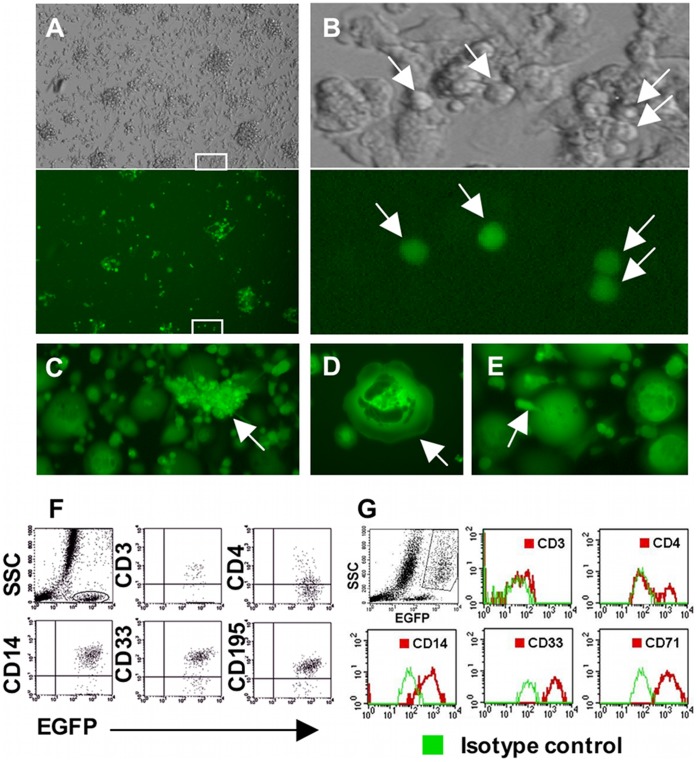
Small monocytoid cells are susceptible to HIV-1 entry leading to productive infection.(A, B) EGFP expression, a marker of productive HIV-1 infection, in cultured MDM at day 5 post infection. Upper panels photographed using phase contrast, and lower panels, which depict identical fields, using fluorescence microscopy. Areas boxed in white in (A) correspond to enlargements shown in (B). The virus-expressing cells (arrows in B) are very small adherent cells at this time. (C) Cluster of tightly associated virus-expressing small cells (arrow) at day 12 post infection. (D) Virus-expressing large macrophage with nurse cell morphology (arrow) at day 21 post infection. (E) Small, HIV-1-expressing cell budding from an infected large macrophage (arrow). (F) EGFP expression in nonadherent small monocytoid cells harvested at day 23 post infection. Small EGFP+ cells were gated as shown in the upper left panel. The other plots were based on the gated population. As can be seen, these small cells express CD14 and CD33 and lack CD3, indicative of a macrophage lineage phenotype. In the upper center plot, most of the EGFP+CD3- cells hug the X-axis. (G) EGFP expression in maturing macrophages harvested at day 9 post infection. The gated population of large macrophages is identified in the upper left panel. Because large macrophages have high levels of autofluorescence, the data are shown with isotype controls. Magnification: (A) x100, (C) x200, (D, E) x400.